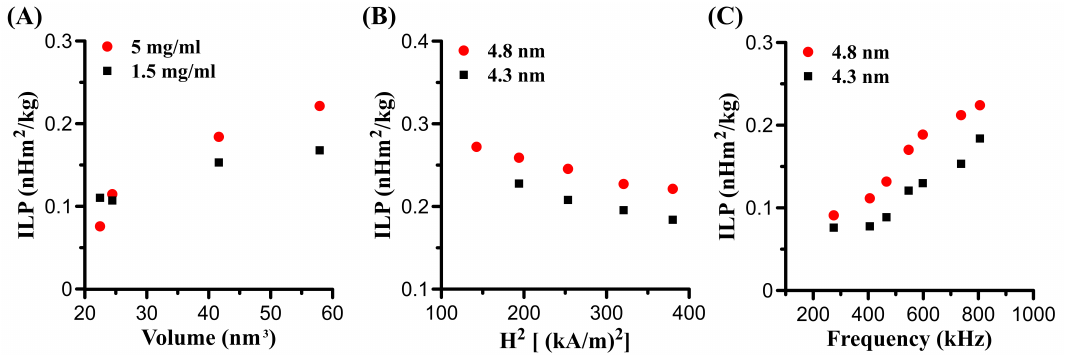
Figure 10. The intrinsic loss power (ILP) vs. di ff erent factors. ( A ) ILP vs. particles volume. MeasurementswereperformedatH = 19.5kA / mand f = 805.5kHz. ( B )ILPvs. frequency. Measurements were performed at c (4.8 nm) = c (4.3 nm) = 5 mg[Fe] / mL, H = 19.5 kA / m. ( C ) ILP vs. amplitude. Measurements were performed at c (4.8 nm) = c (4.3 nm) = 5 mg[Fe] / mL, f = 805.5